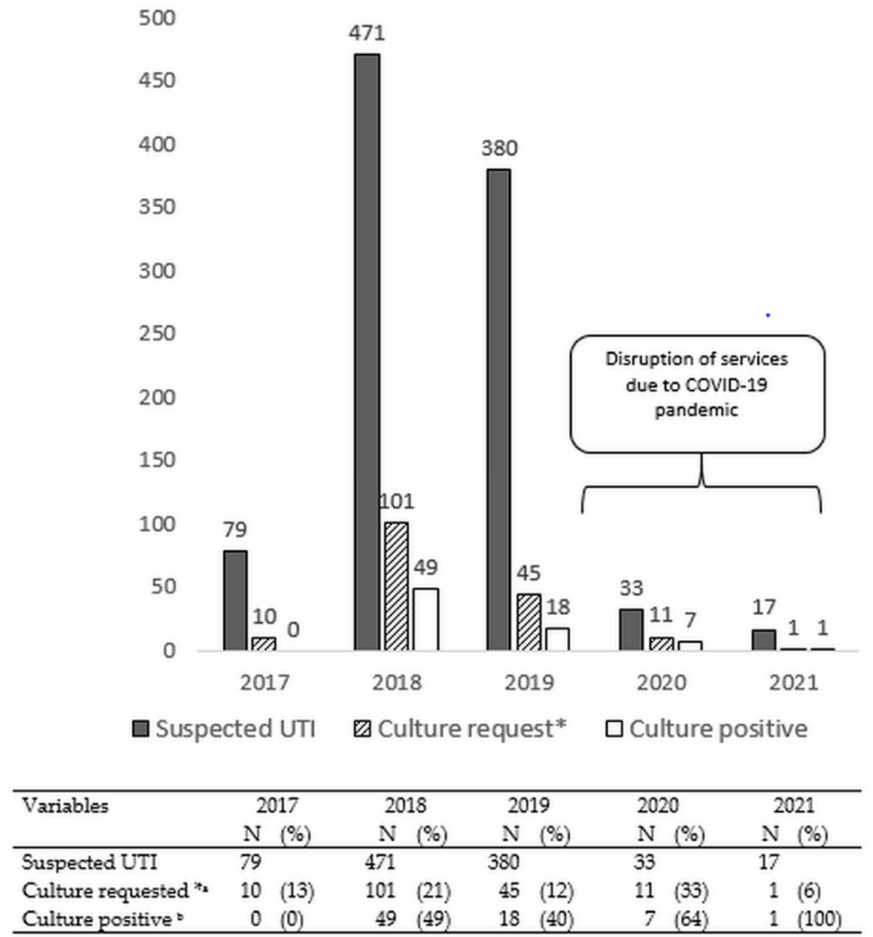
Figure 2. Numbers of patients with suspected urinary tract infections, culture requests, and those processed through to positive cultures in the two hospitals in Freetown, Sierra Leone, between May 2017 and May 2021. UTI—urinary tract infection; * all culture requests underwent urine culture; a denominator is suspected UTI; b denominator is culture